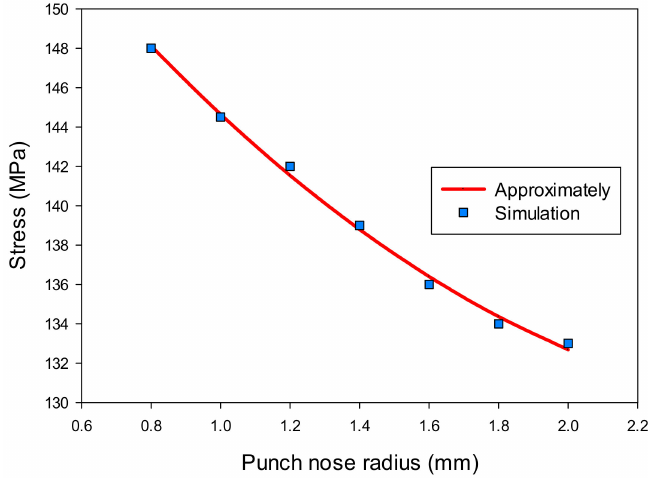
Figure 16. The effect of punch nose radius on